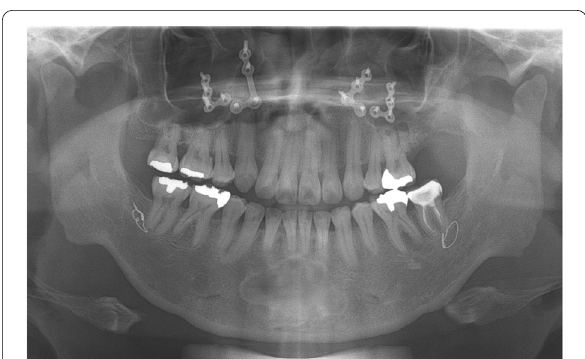
Fig. 4 Follow‑up panoramic view 7 months after surgery. The defect in the area of the cystic cavity was filled with bone that was comparable with the surrounding bone, and no sign of recurrence was